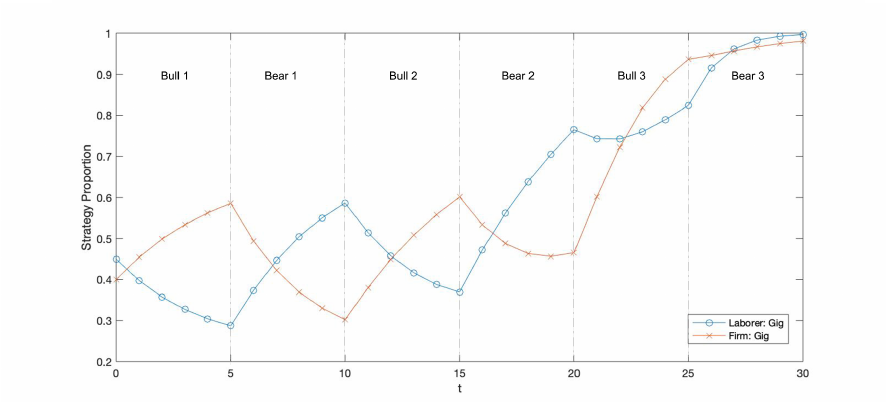
Figure A4. Escape demonstration with initial conditions ( 0.45,0.40 ) , ω = 0.1 and n = 1 and theoretical GameState pair, see Figure